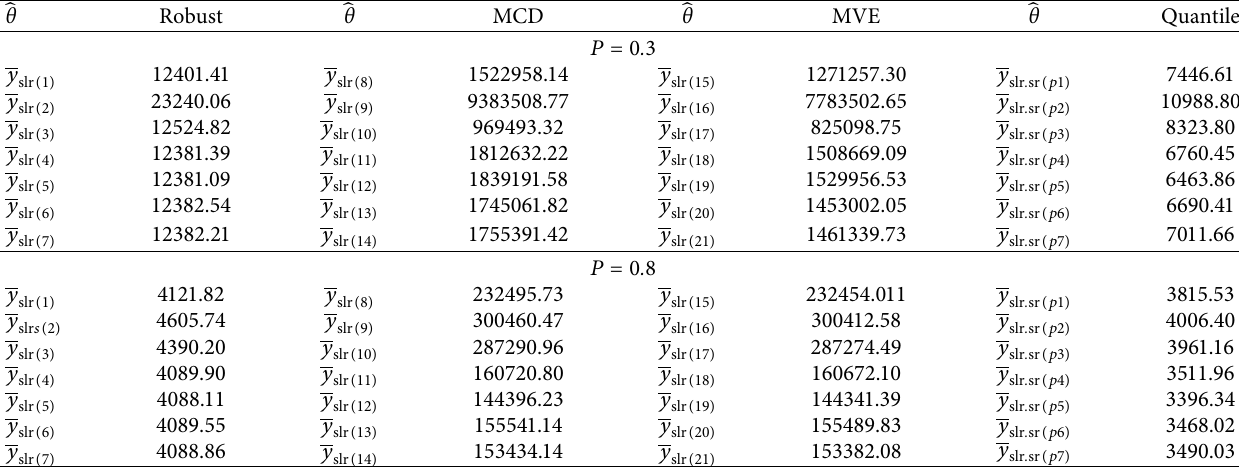
Table 6: Population-1 MSE for the mean estimators of the sensitive variable through using the Bar–Lev model. 􏽢